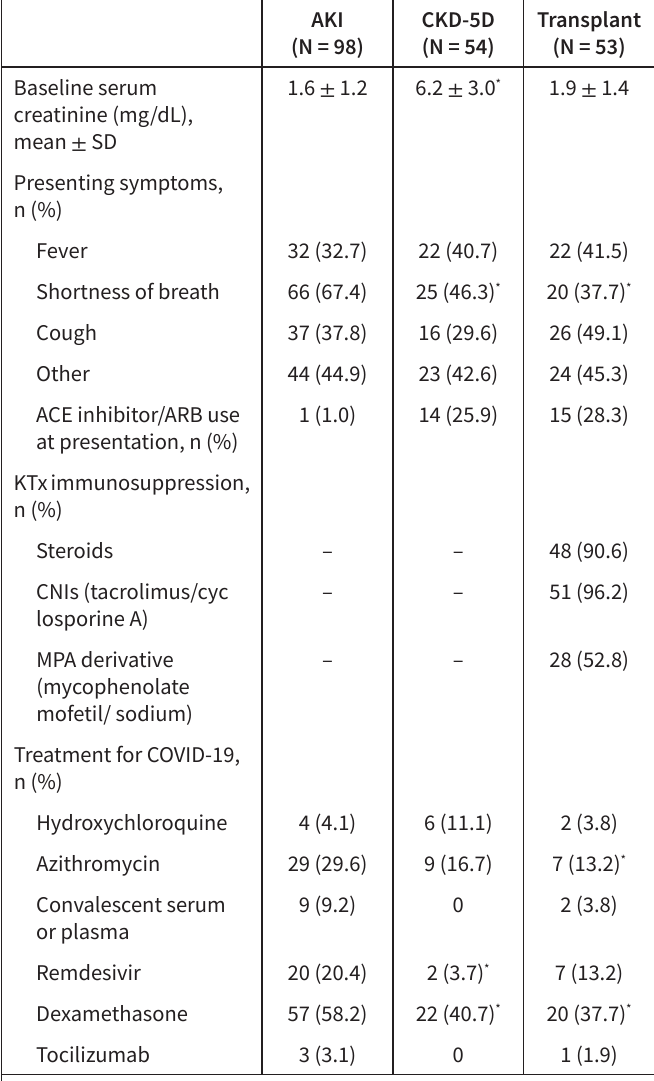
Table 2. Presenting Clinical Characteristics and Treatments in the